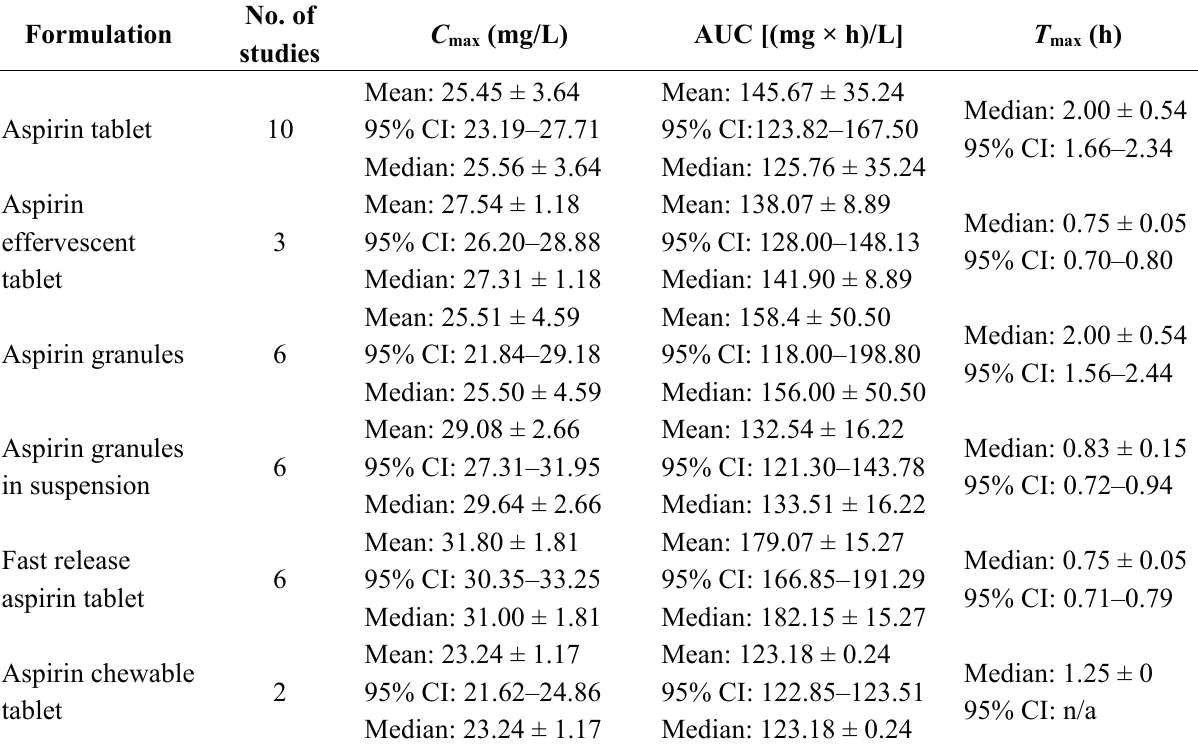
Table 2. Summary pharmacokinetic data of salicylic acid for aspirin formulations.